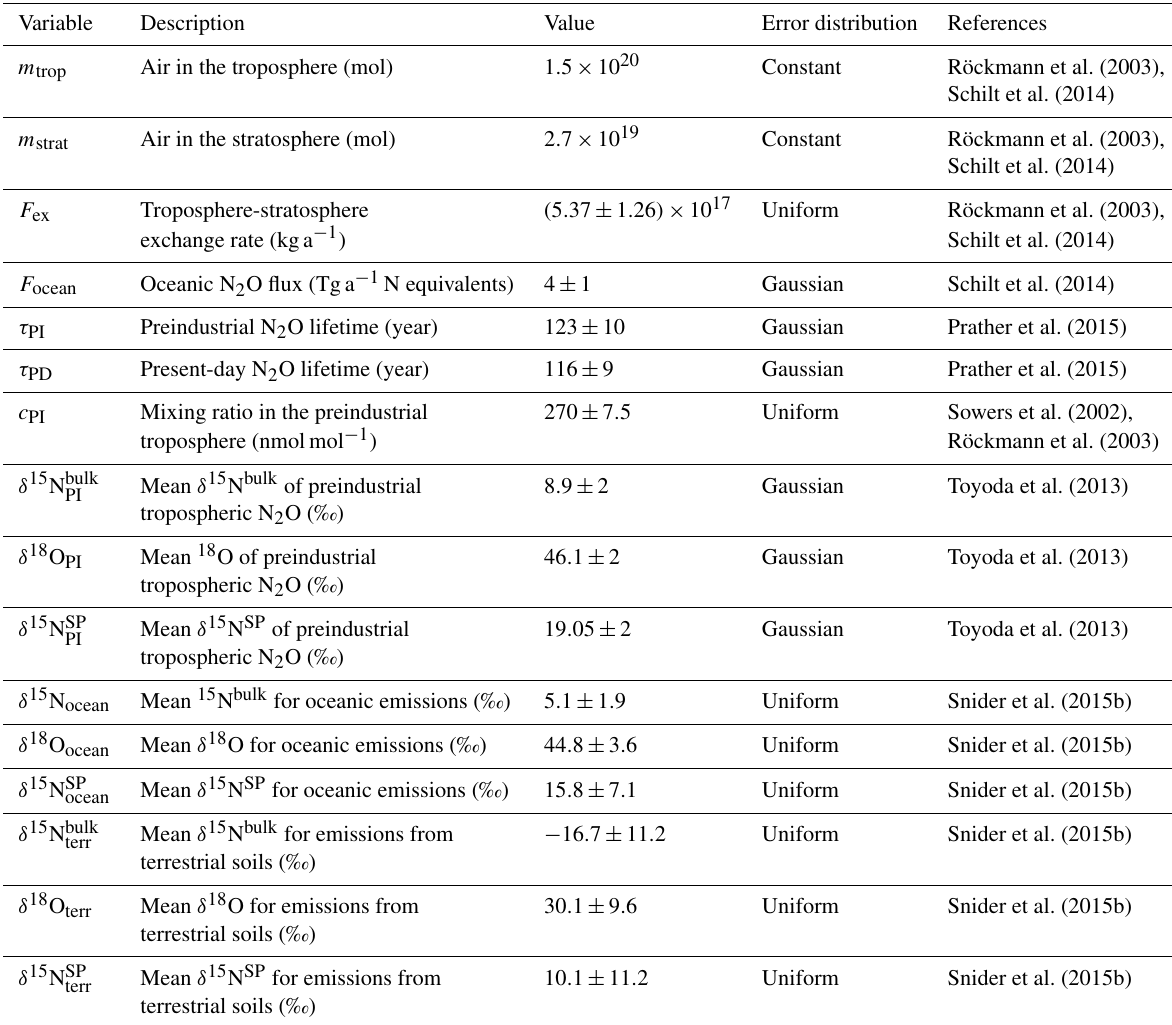
Table 2. Input variables for simple two-box